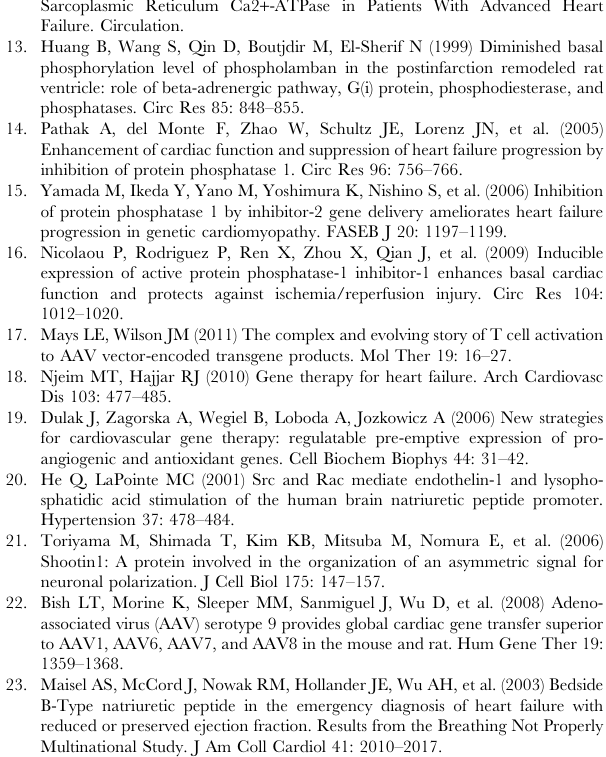
Figure S4 Immunoblottings of cardiac troponin I, SERCA2a, and PP1 catalytic subunit a and c in LV homegenates from AAV9-transfected mice heart. LV specimens were obtained at 3 month after tail-vein-mediated AAV9 gene transfer. Table S1 Sequence information for shRNA and real- time PCR analysis. The bold characters in the mouse PP1 b shRNA and mouse NCshRNA indicate 5 9 -overhang se- quence for the directed ligation reaction with pcDNA6.2-GW/ EmGFP-miR plasmid. Table S2 Serial echocardiogram data after AdV vector injection. Abbreviations in the table are as follows; GT: gene transfer, %FS: % fractional shortening of the left ventricle, LVDd: left ventricular end-diastolic dimension, LVDs: left ventricular end-systolic dimension, LVPWs: left ventricular posterior wall thickness at systole. ‘‘*’’ indicates p , 0.01 vs. NC-shRNA group (Post GT), n= 14 in each